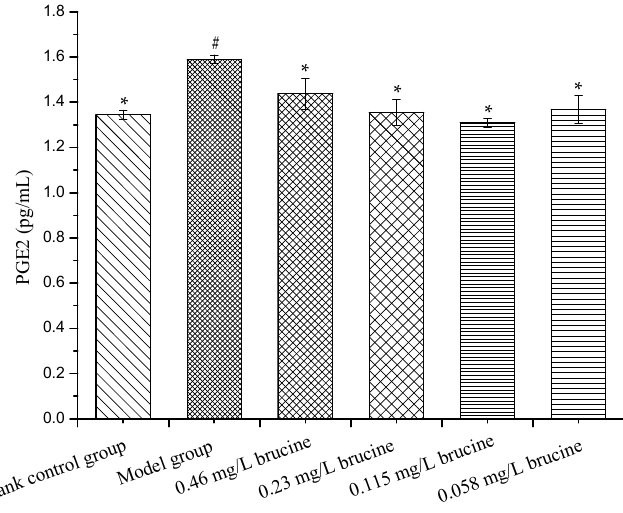
Figure 9. Effects of brucine on Prostaglandin E2 (PGE2) production. Symbols represent statistical significance: # ( p < 0.05) when compared with blank control group and * ( p < 0.05) when compared with model group.